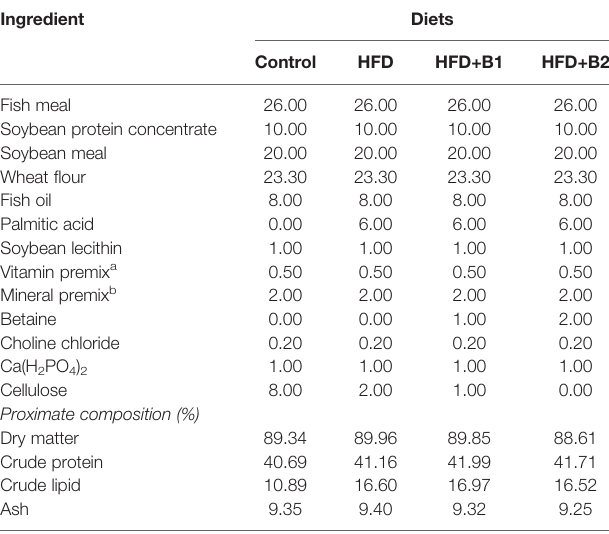
TABLE 1 | Formulation and composition of the experimental diets (%dry matter). Ingredient Diets